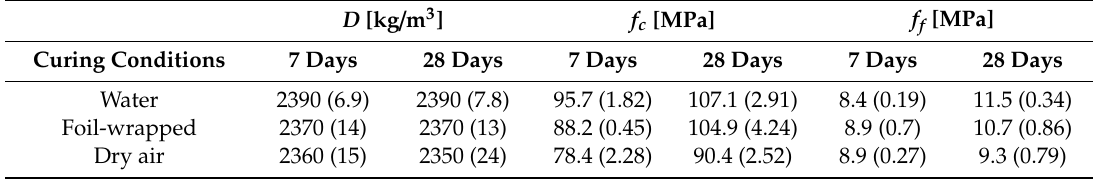
Table 2. Bulk density ( D ), compressive strength ( f c ) and flexural tensile strength ( f f ) of the hardened Self-Compacting High-Performance Concrete: Average value (sample standard deviation).